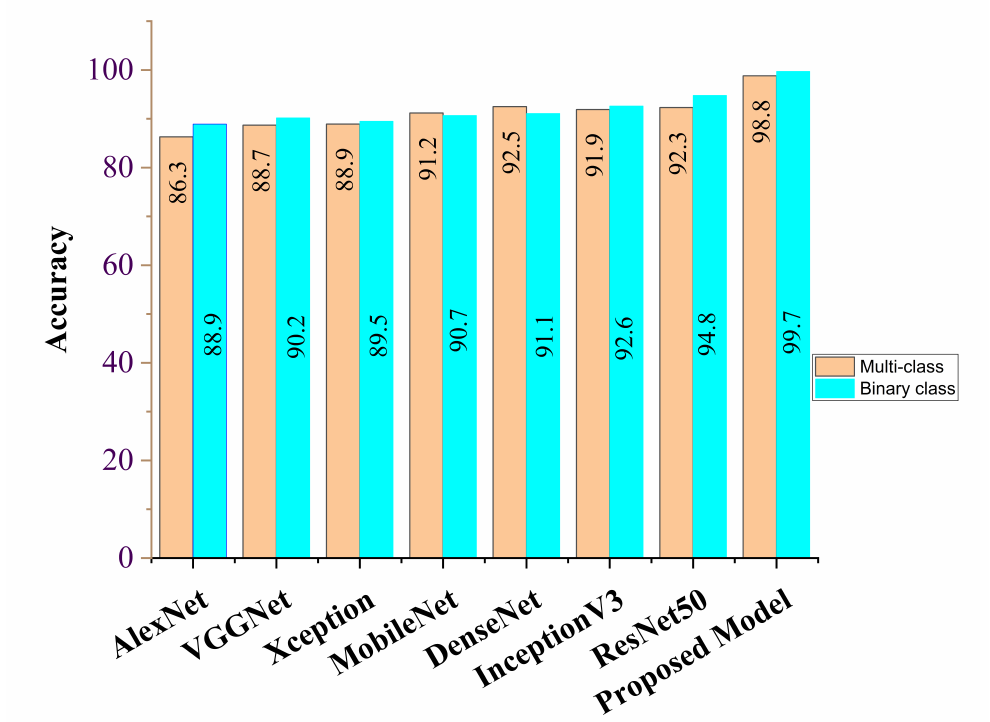
Figure 7. Accuracy report for our proposed model and selected pre-trained models for binary class and